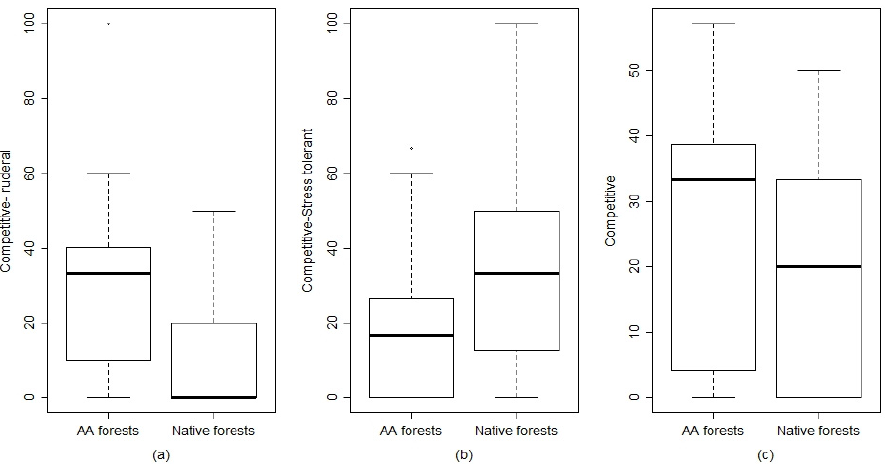
Figure 3. Comparison of the significant Grime strategies between A. altissima (AA forests) and native forests. ( a ) Competitive-ruderal p value = 0.008 ** ; ( b ) Competitive-stress tolerant p value = 0.005 ** ;